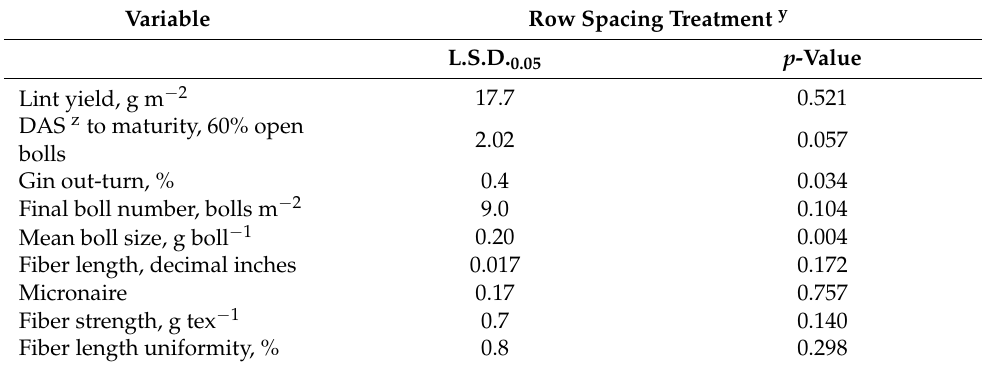
Table 3. Summary of significant differences from combined analysis of experiments for lint yield, maturity, yield components, and fibre quality. Error df = 28, row spacing treatment df = 1, experiment df = 4, and spacing × experiment df = 4 for all variables except for boll number and boll size where error df = 22, row spacing treatment df = 1, experiment df = 3, and spacing × experiment df